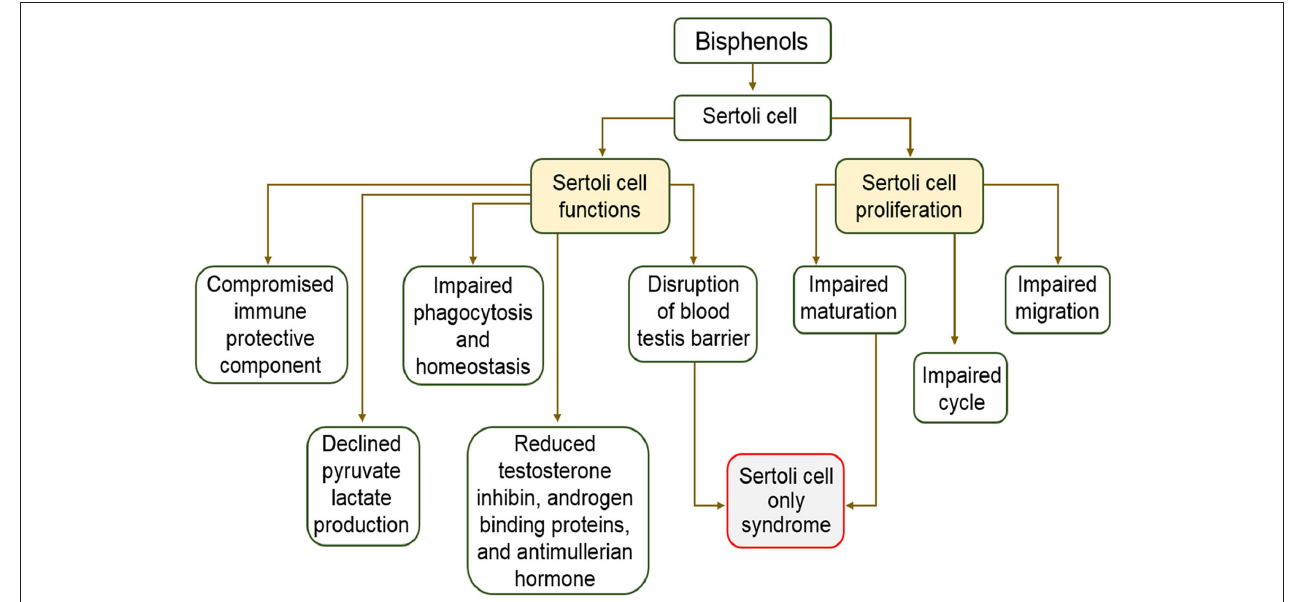
FIGURE 3 | Schematic description of the effects of bisphenols on Sertoli cells and male reproductive